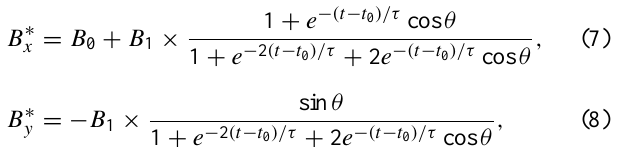
Table 3. Results from the fit of the magnetic field X -component to Eq. (7). θ is calculated from Eq. (11). B 0 is the initial asymptotic value of the magnetic field, B 1 the increase of the magnetic field, t 0 the midpoint of the rise, τ the characteristic time scale from the fit and τ i the initial guess according to Eq. (9).